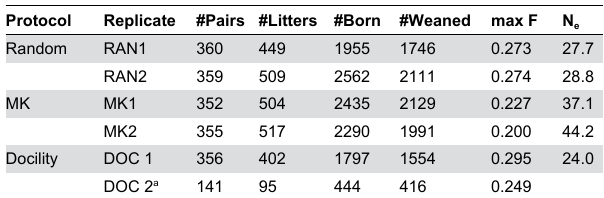
Table 1. Sample sizes across generations 1 through 18, in each of 6 experimental populations of Peromyscus leucopus mice, with the maximum level of inbreeding (F) accumulated in each population and the effective population size (N ) over the 18 e